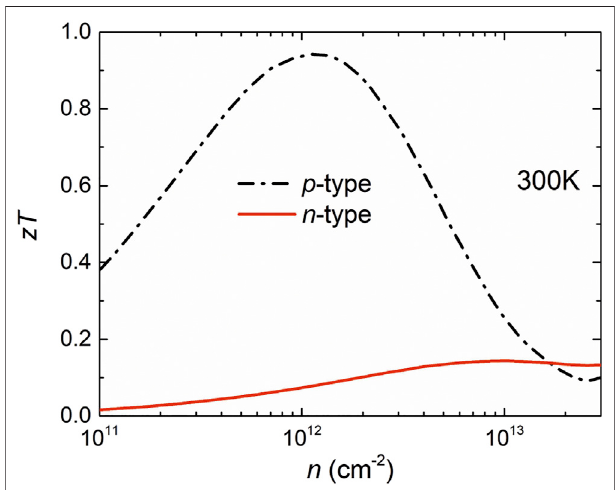
FIGURE 5 | Calculated thermoelectric fi gure of merit at 300